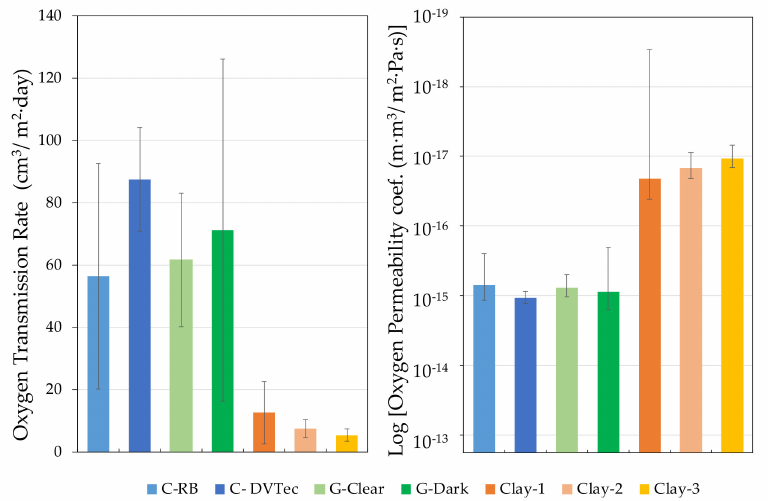
Figure 13. Variation of permeation properties in liquid contact mode (Tartaric acid conditioned for